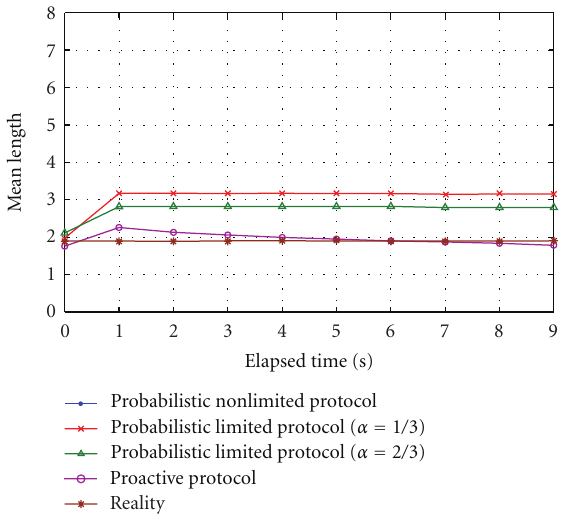
Figure 3: Average route length for α = 1 / 3 and α = 2 / 3, V = 0m/sec.